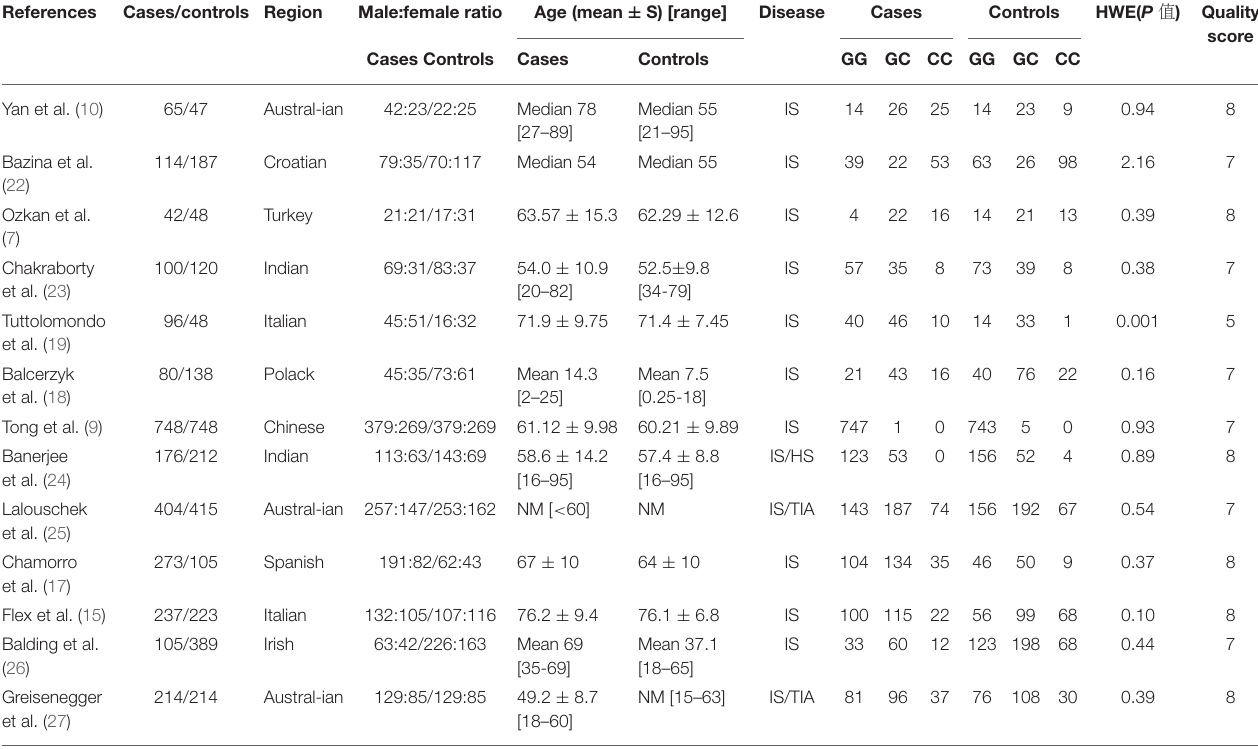
TABLE 1 | Main characteristics of studies